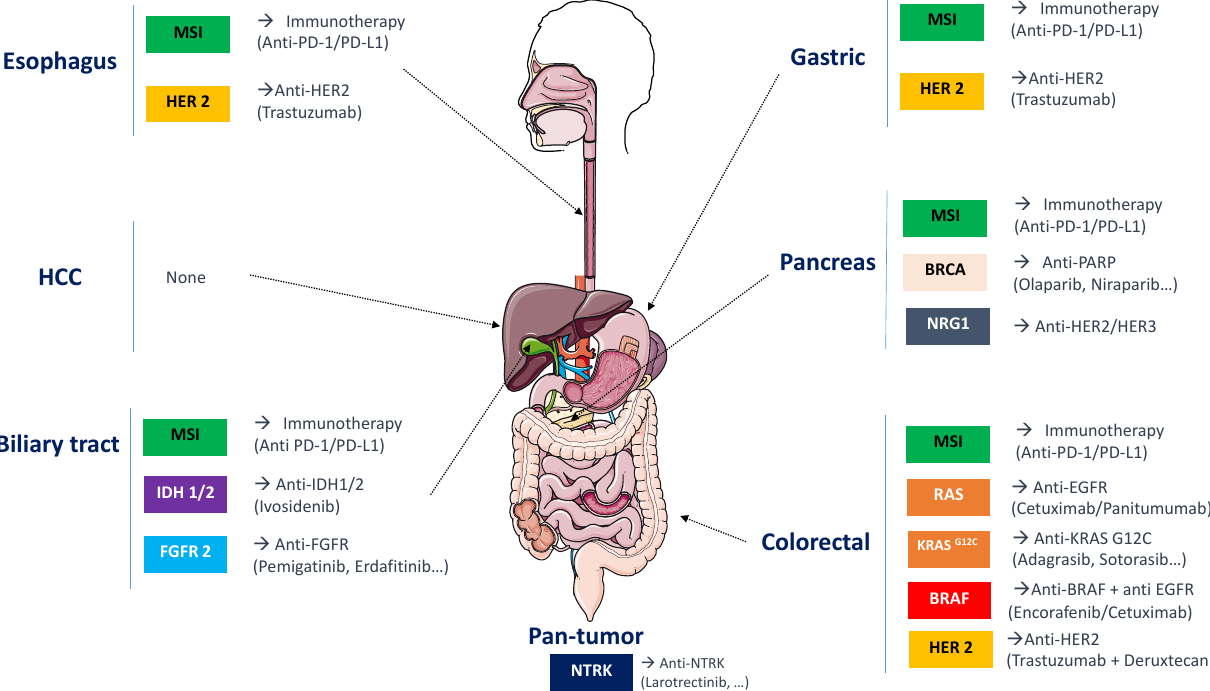
Figure 2. Major molecular abnormalities in digestive cancers and current treatment